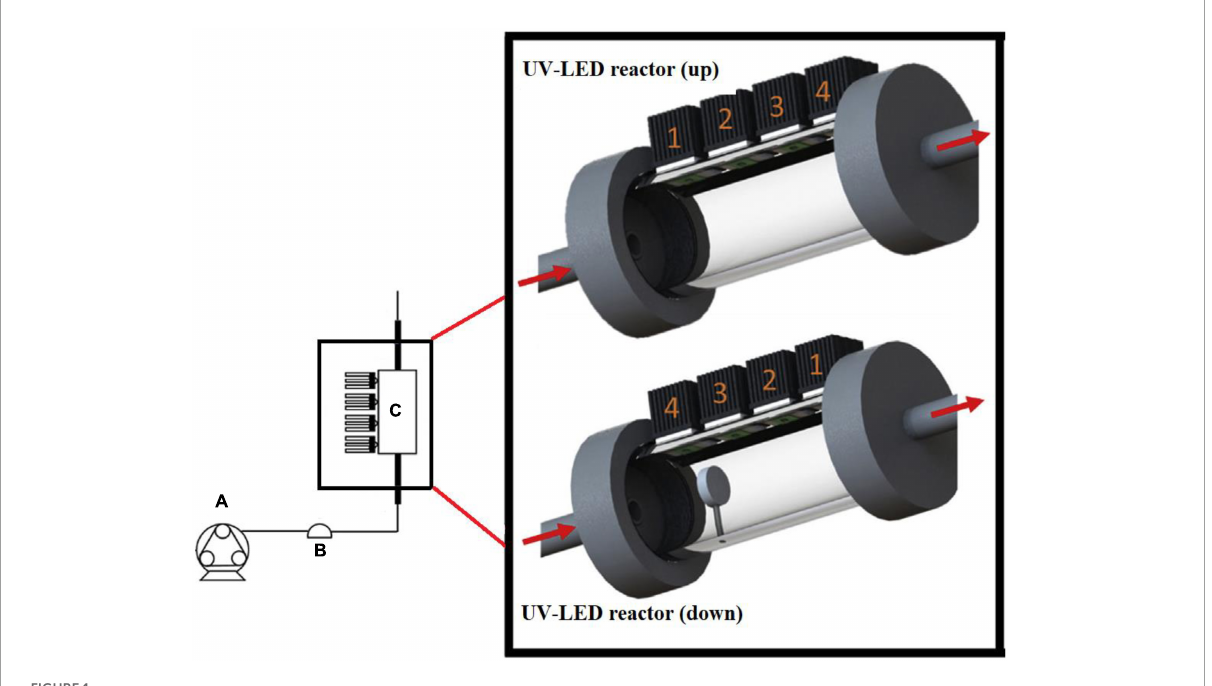
FIGURE1 Scheme of the flow-through ultraviolet light emitting diode (UV-LED) reactor setup: (A) Peristaltic pump, (B) Pulse dampener, (C) UV-LED reactor (up/down). Adapted from Keshavarzfathy et al. (23).